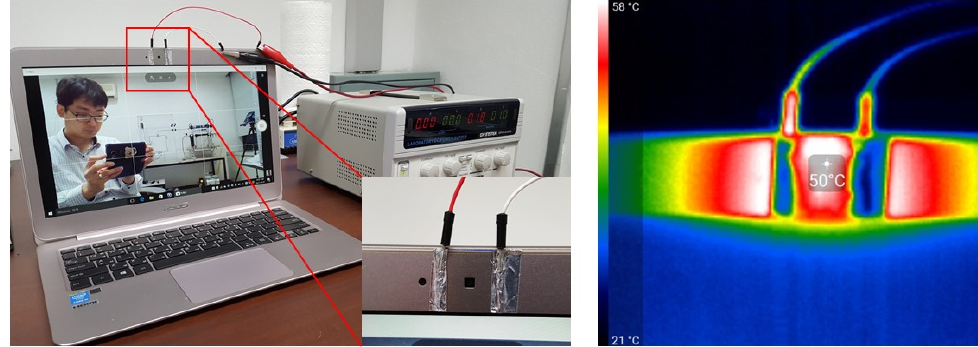
Figure 3. Photograph and infrared (IR) images of the ITO / Ag / ITO multilayer transparent heater attached to the built-in webcam of a laptop.